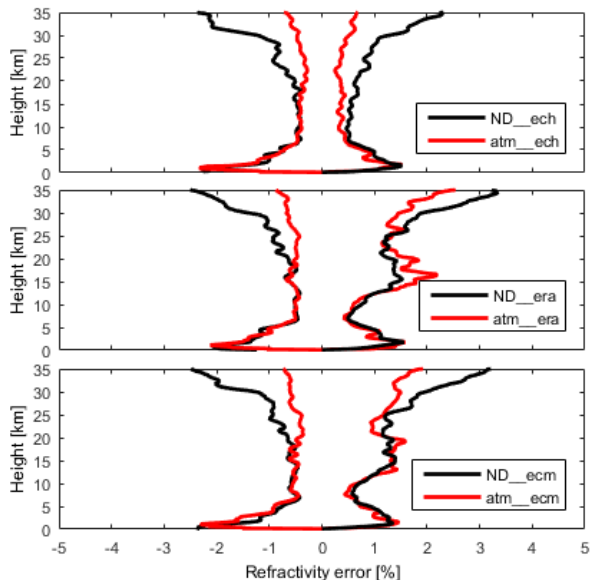
Figure 7. The mean relative refractivity deviation compared R_N and atmPrf with ECMWF analyses in rising RO events. ND_ech represents the average relative refractivity deviation between ND- derived and echPrf; atm_ech denotes the average relative refractiv- ity deviation between atmPrf and echPrf; ND_era shows the av- erage relative refractivity deviation between ND-derived and er- aPrf; atm_era expresses the average relative refractivity deviation between atmPrf and eraPrf; ND_ecm is the average relative refrac- tivity deviation between ND-derived and ecmPrf; atm_ecm signifies the average relative refractivity deviation between atmPrf and ecm- Prf; R_N is the refractivity derived from ND-derived AEP for the selected 200 RO events based on ROPP